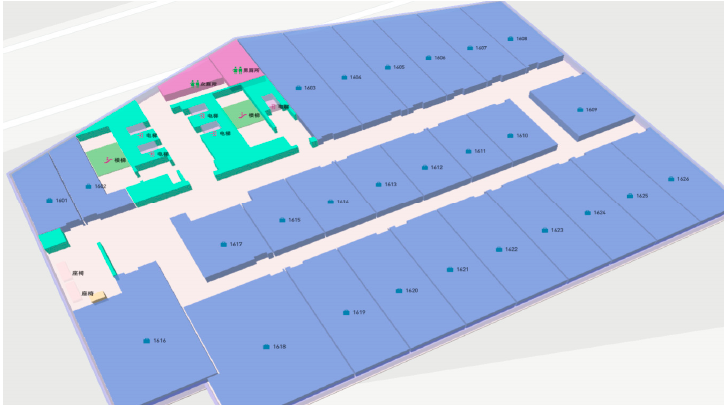
Figure 9. Map of the test environment.